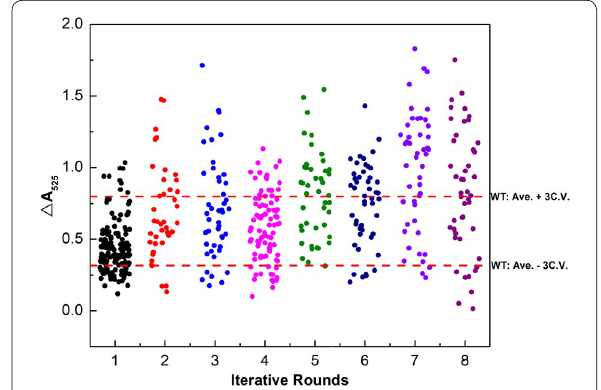
Fig. 3 Distribution of screening results for each round of ARTP mutagenesis. (cid:31) A 525 = A 525, Sample − A 525, contorl , which is proportional to the TGase